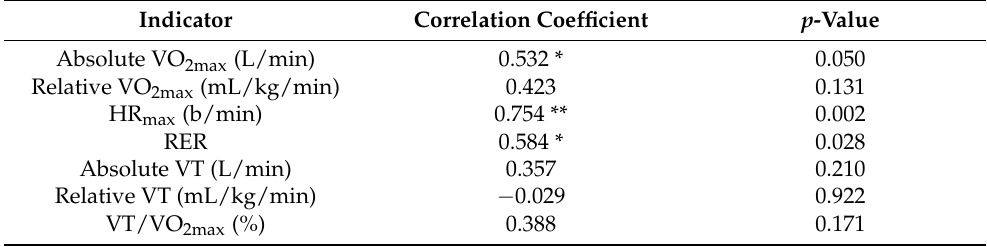
Table 9. Correlation analysis of the Results from the Cycling Aerobic Test and OIST ( n = 14). Indicator Correlation Coefficient